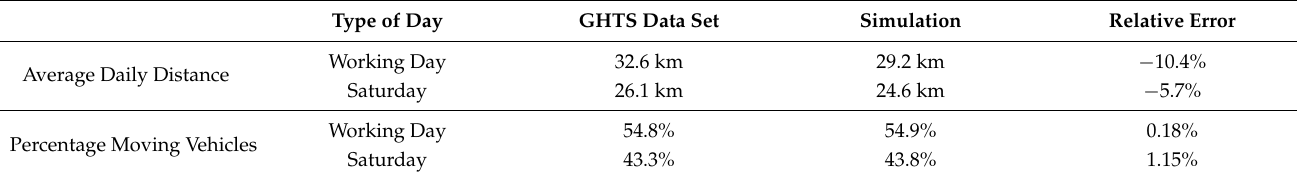
Table 3. Comparison of the simulation and the GHTS data set—average daily distance and moving vehicles. Type of Day GHTS Data Set Simulation Relative Error Average Daily